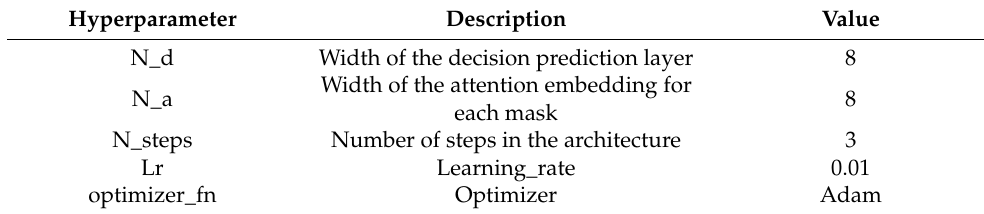
Table 4. The hyperparameter settings of